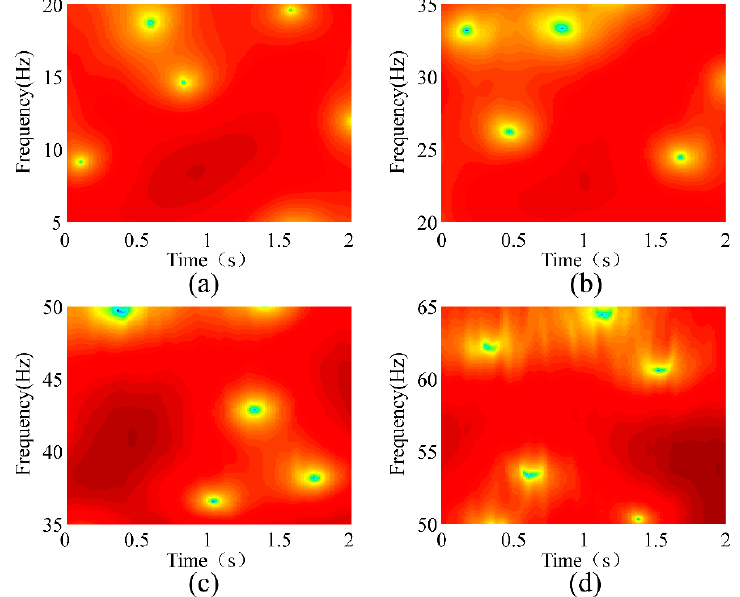
Figure 13. STFT analysis of the conductor’s vibration responses at a wind velocity of 2.2 m/s. ( a ) 1st Mode; ( b ) 2nd Mode; ( c ) 3rd Mode; ( d ) 4th Mode.